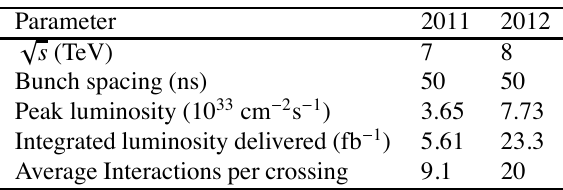
Table 1. Selected LHC operational parameters for pp